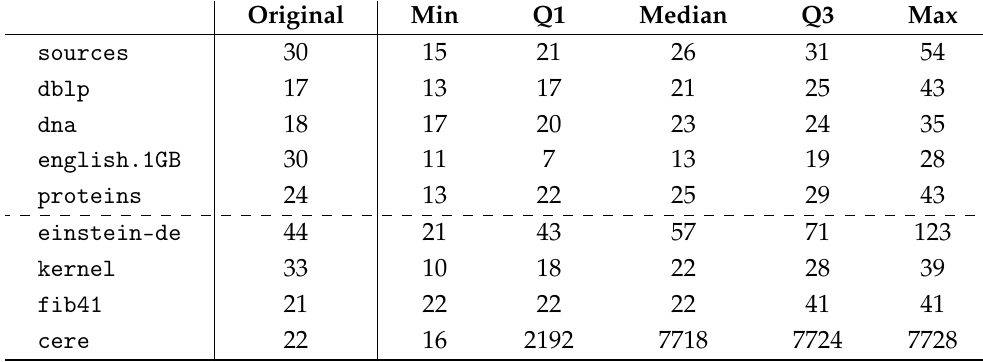
Figure 2. Longest Lyndon factor length for each method. Grey points are outliers in the random distributions. Table 2. Number of Lyndon factors for random permutations of the alphabet. Column 2 shows the number of factors for the original alphabet. Columns 3 and 7 show the minimum and maximum number of factors obtained with 100 random permutations of the alphabet. Columns 4, 5 and 6 show the first quartile (Q1), the median and the third quartile (Q3) of the